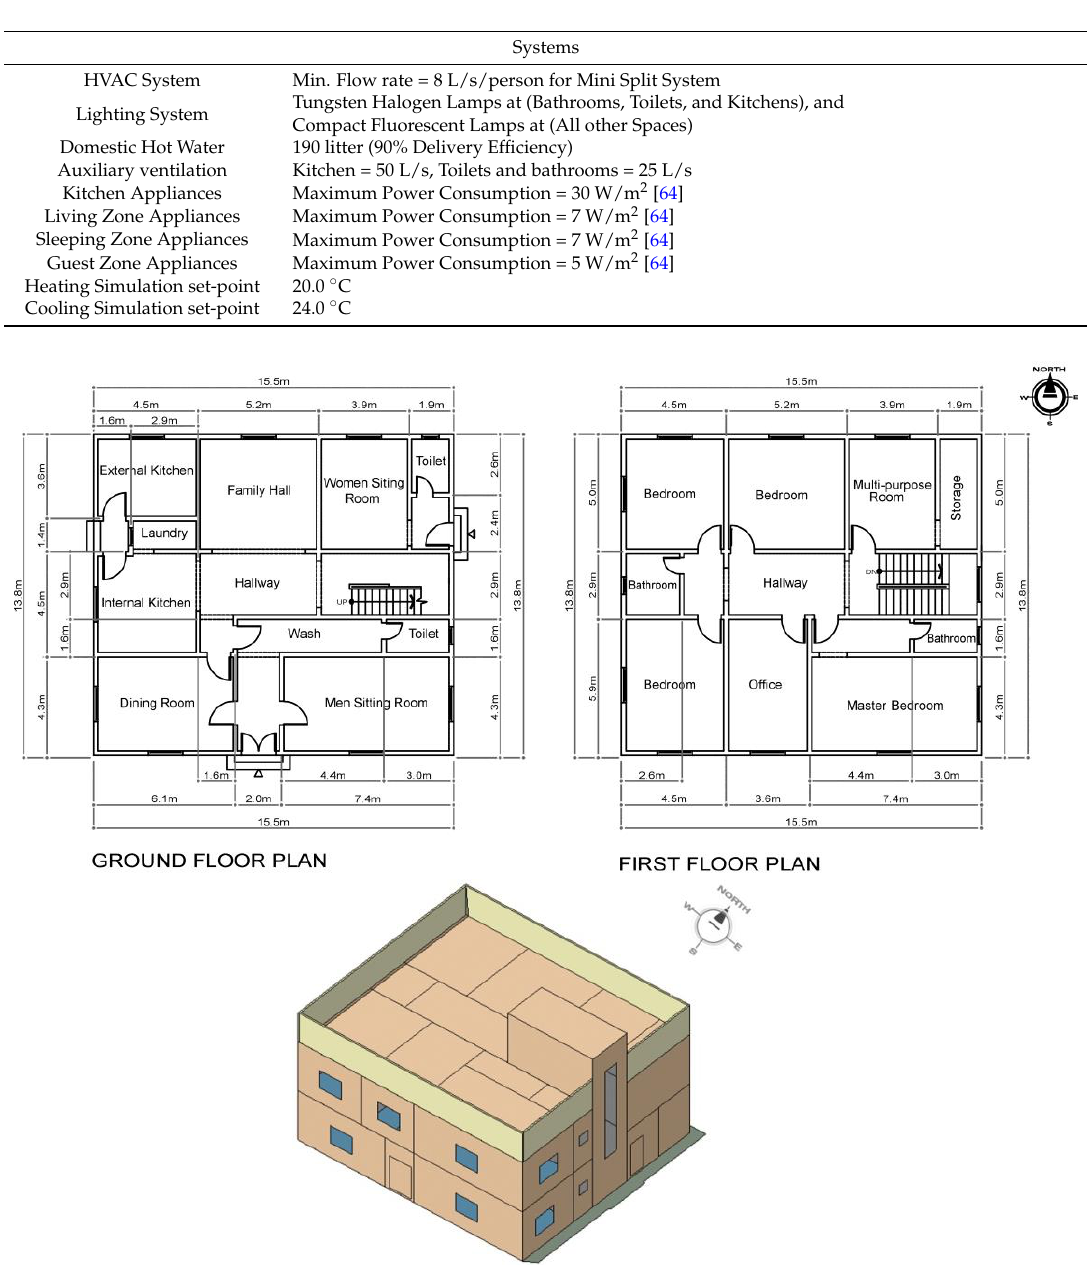
Figure 9. Model and floor plans for the base house. Table 2. Key features of the base house.